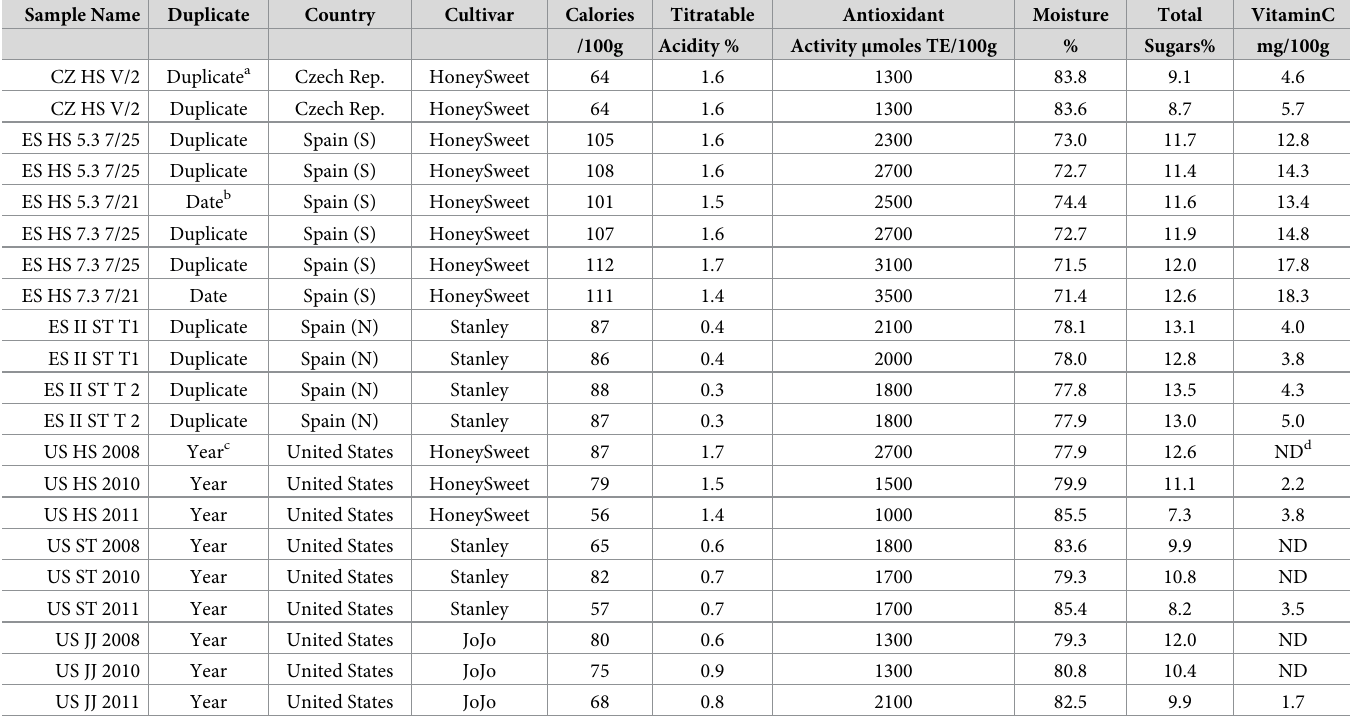
Table 3. Subset of composition components of duplicate samples and multiple collection